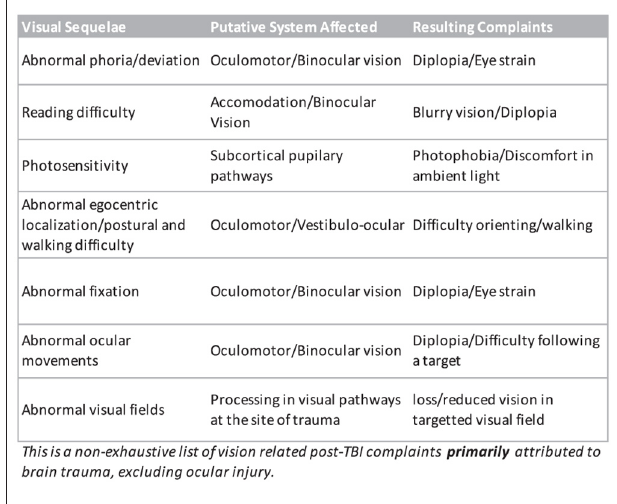
FIGURE 1 | Non-exhaustive list of known visual disturbances reported following a traumatic brain